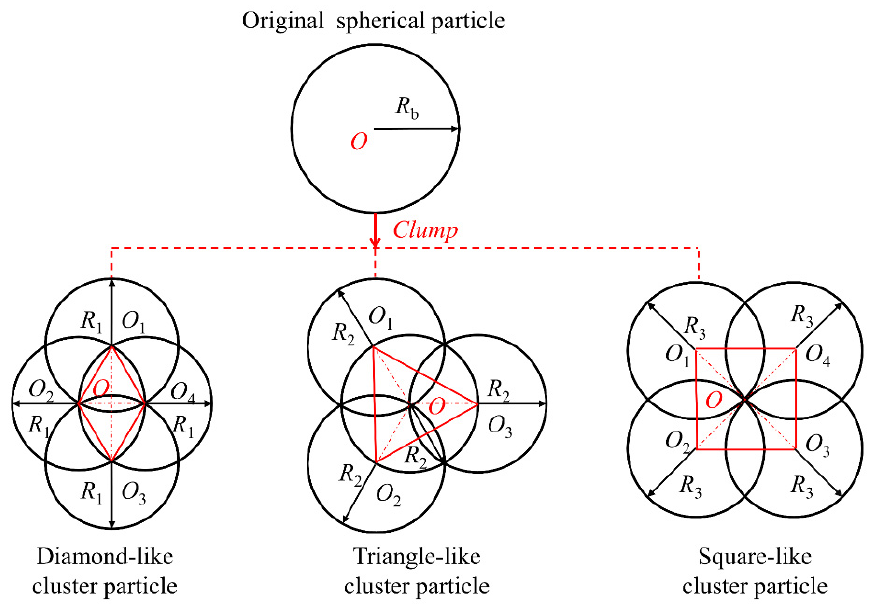
Figure 2. The geometric diagram of the cluster particles. Based on the principle that the volume, mass, and center of gravity remain unchanged before and after conversion, the radius and density of the sub-particles of the three types of the cluster particles after conversion can be defined as: